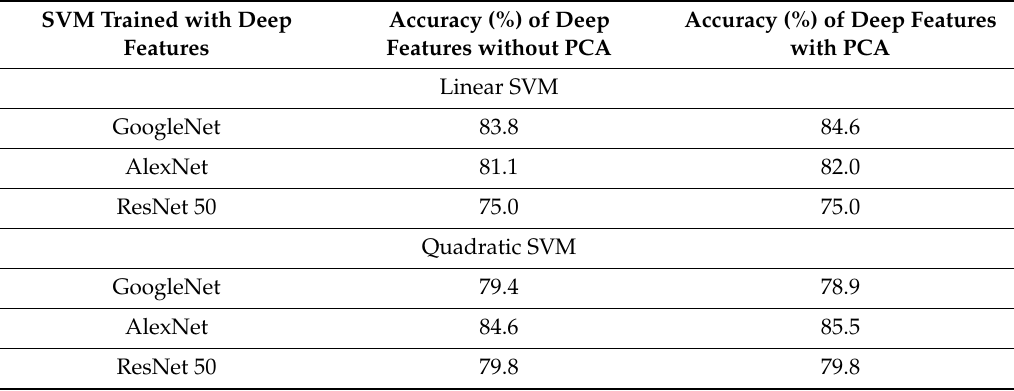
Table 5. The accuracy of the support vector machine (SVM) classifiers trained with GoogleNet, AlexNet, and ResNet 50 DCNNs. PCA—principal component